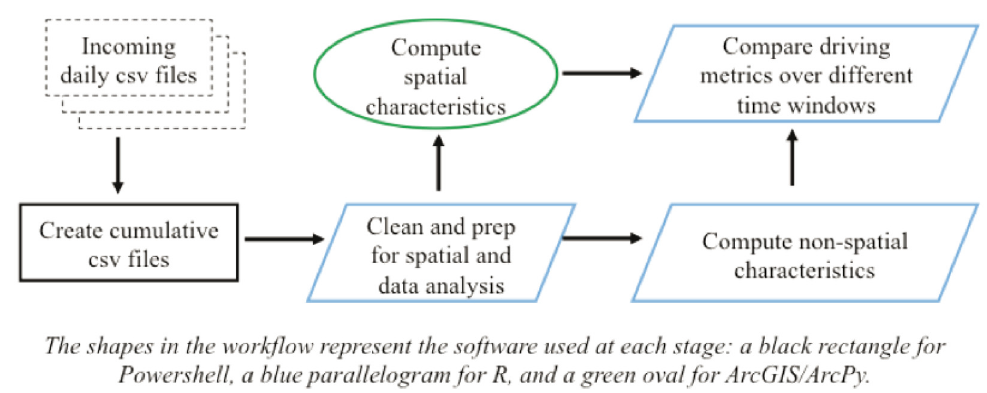
Figure 1. Data workflow required to generate driving metrics over different time